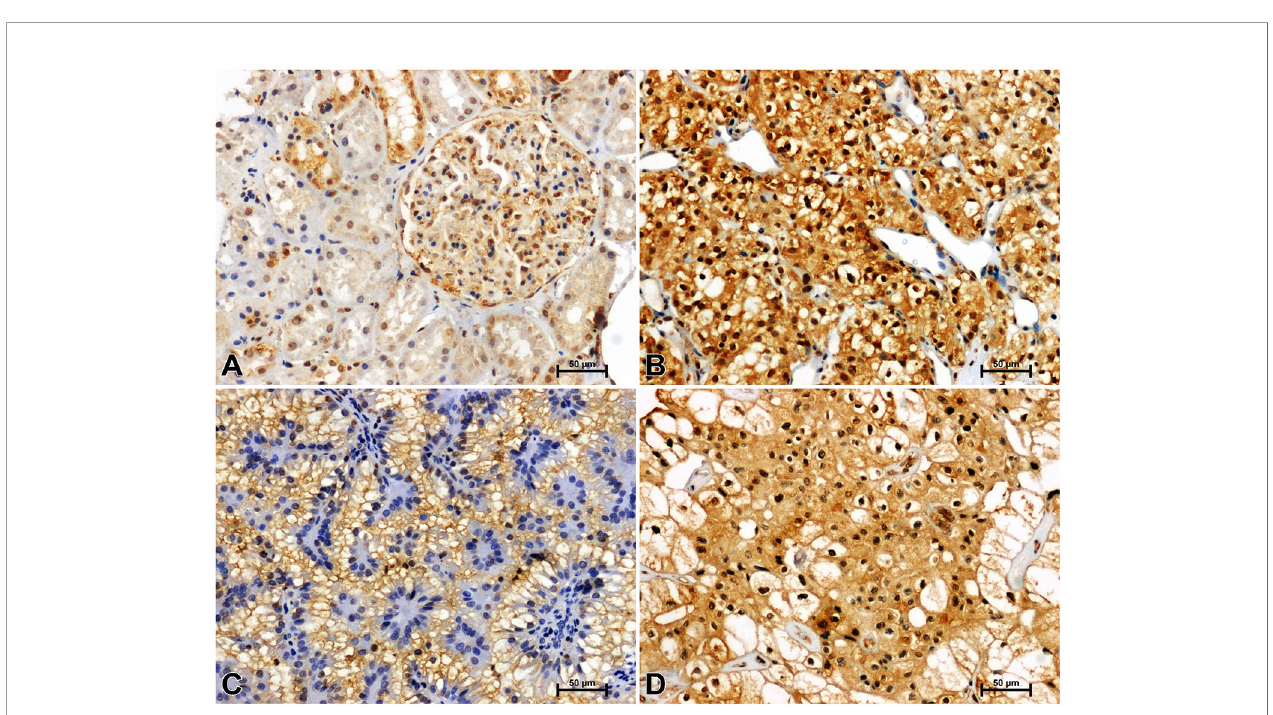
FIGURE 6 | Representative immunohistochemical photomicrographs of LMP7 in non-malignant kidney (A) and clear cell RCC (B) , papillary RCC (C) , chromophobe RCC (D) .